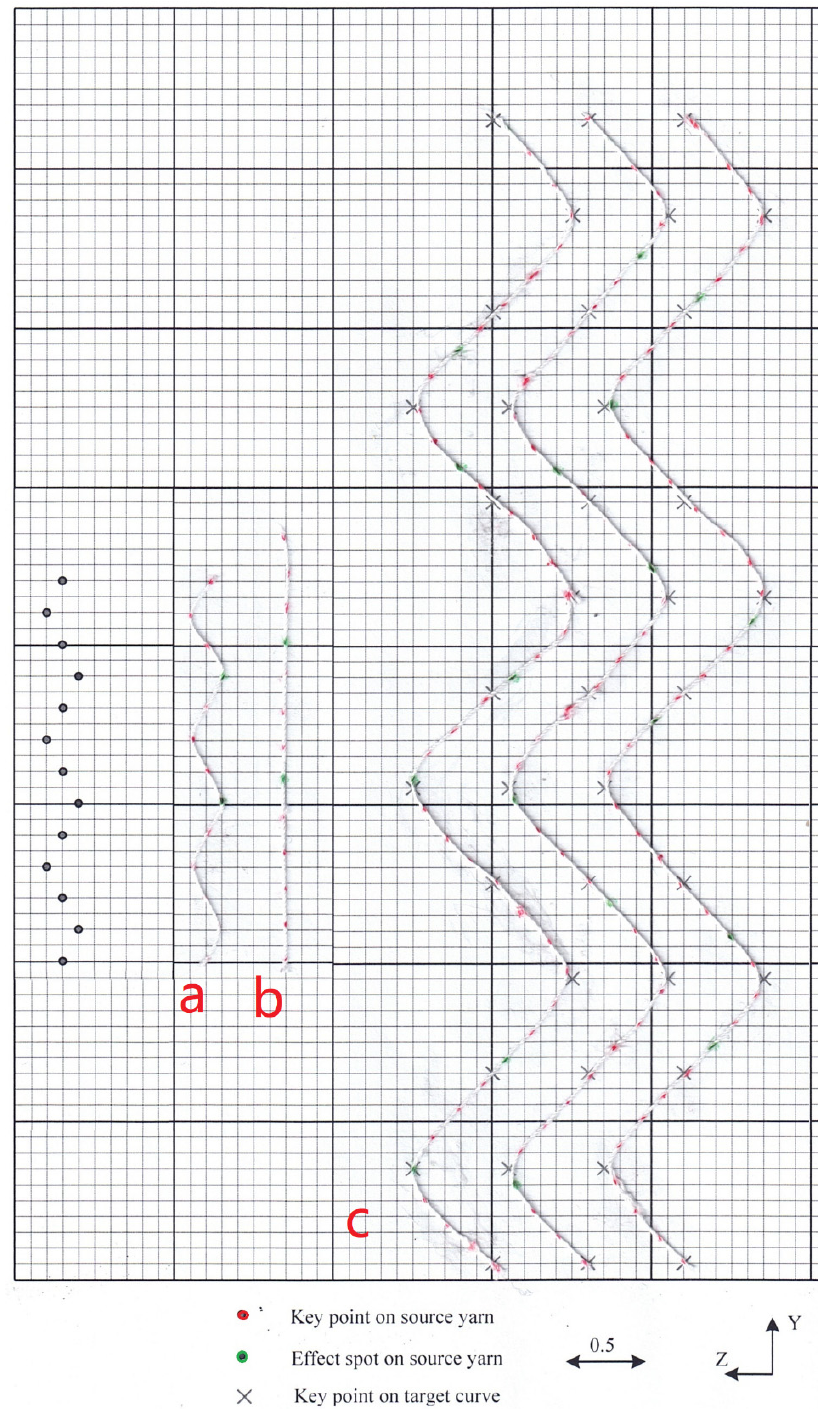
Figure 16. Real effect yarn bending diagram as compared with Figure 14c. ( a ) A full repeat unit of the real bent source yarn corresponding to Appendix A.1. ( b ) A full repeat unit of the